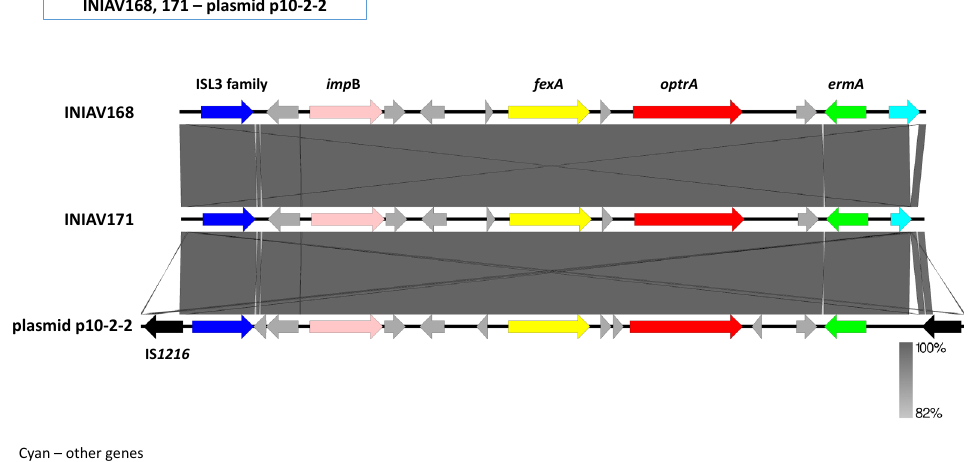
Figure 4. Alignment of the optrA -containing contigs of strains INIAV168 and INIAV171 with the previously described optrA -carrying plasmid p10-2-2 (GenBank accession number KT862775).